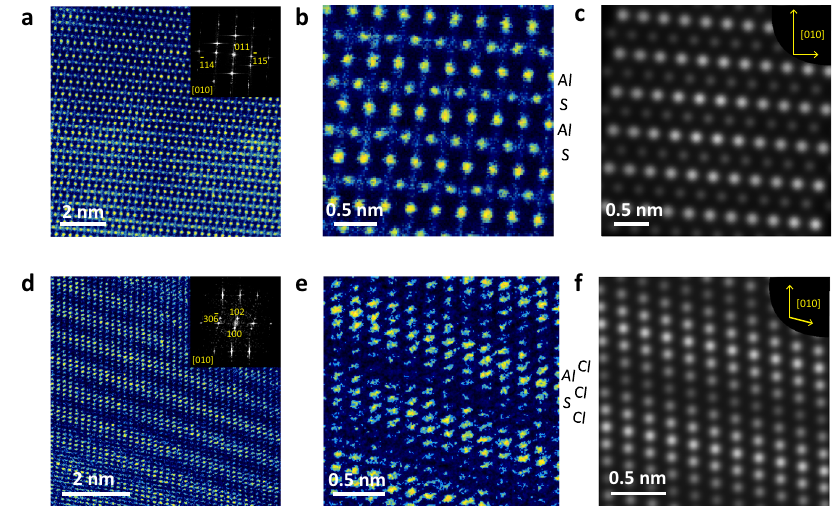
Fig. 2 Microscopic images of reduced and oxidized products of sulfur. a , b STEM image of Al 2 S 3 , and the inset in a shows the FFT patterns; c the simulated microscopic image of Al 2 S 3 observed from [010] direction; d , e high-resolution TEM images of AlSCl 7 , and the inset in d shows the FFT patterns; ( f ) the simulated microscopic image of AlSCl 7 observed from [010]